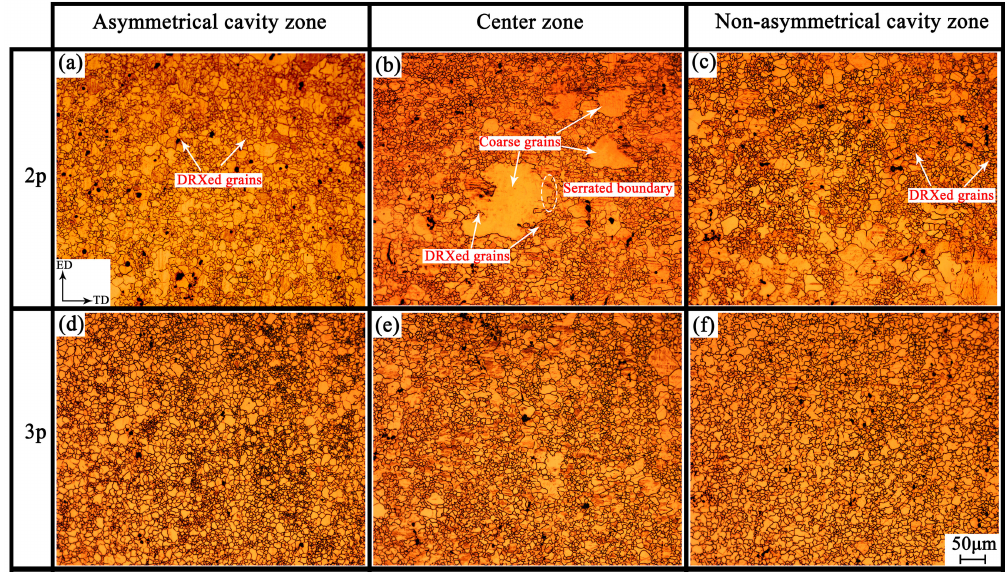
Figure 4. Microstructures of AZ31B alloys processed by CEE-AEC: ( a , b , c ) grain structures of 2 passes of CEE-AEC at asymmetrical cavity zone, center zone and non-asymmetrical cavity zone, respectively; ( d , e , f ) grain structures of 3 passes of CEE-AEC at asymmetrical cavity zone, center zone and non-asymmetrical cavity zone, respectively. (All the figures have the same scale